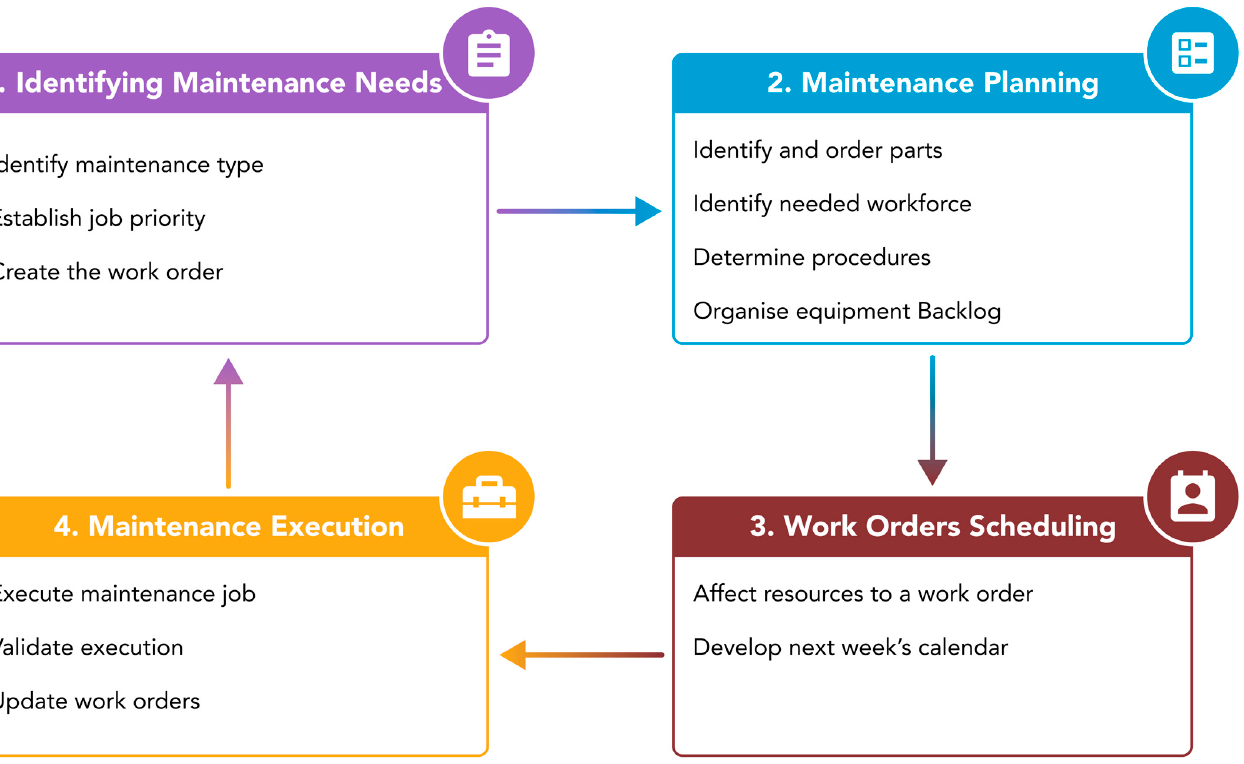
Figure 4. The maintenance